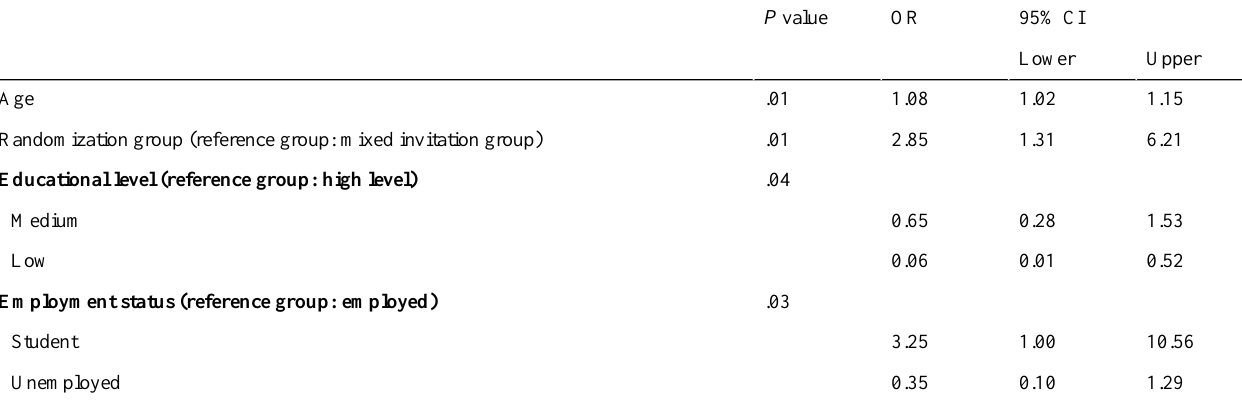
Table 3. Factors associated with the probability of filling out the Web-based version of the questionnaire: results of logistic